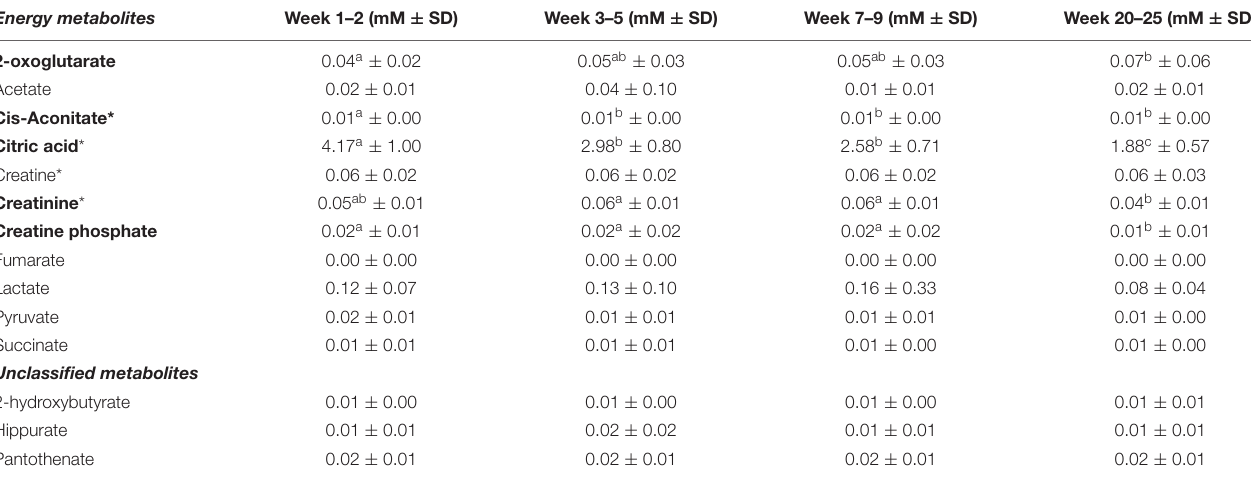
TABLE 5 | Mean levels (in mM ± standard deviation) of metabolites related to energy metabolism in human milk from term deliveries sampled weeks 1–2, 3–5, 7–9, and 20–25